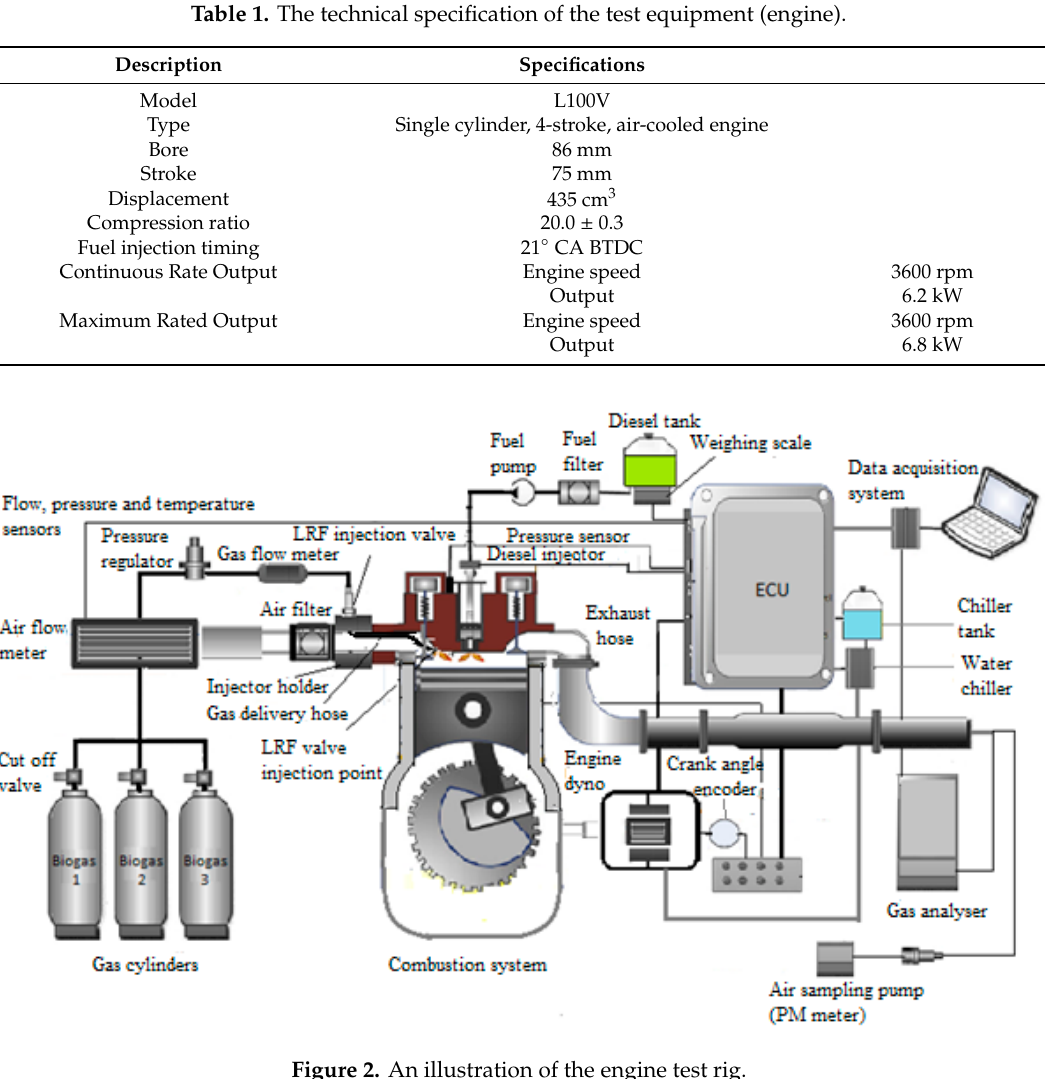
Table 1. The technical specification of the test equipment (engine) .